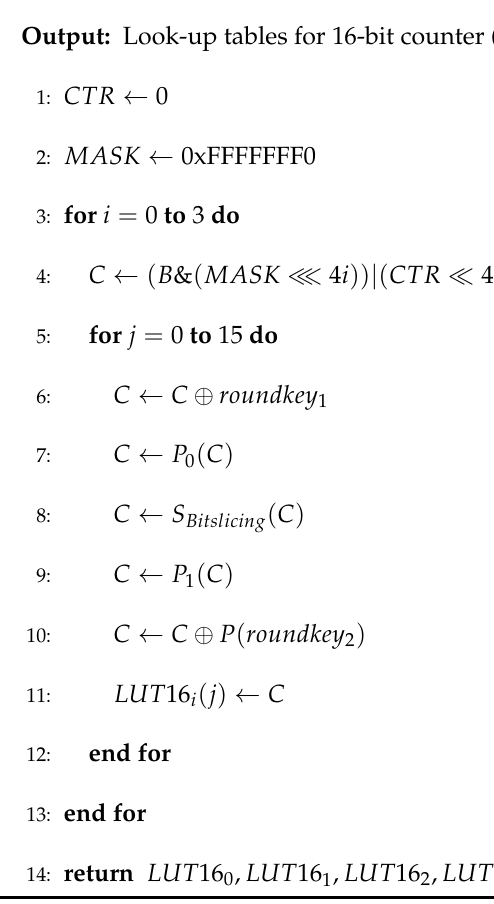
Algorithm 4: Generation of look-up tables for proposed PRESENT-CTR16 en-